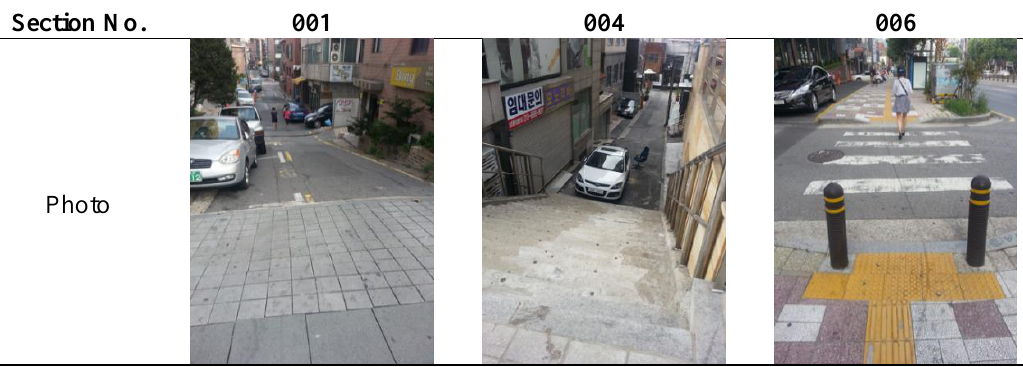
Table 6. Examples of collected data of facilities and